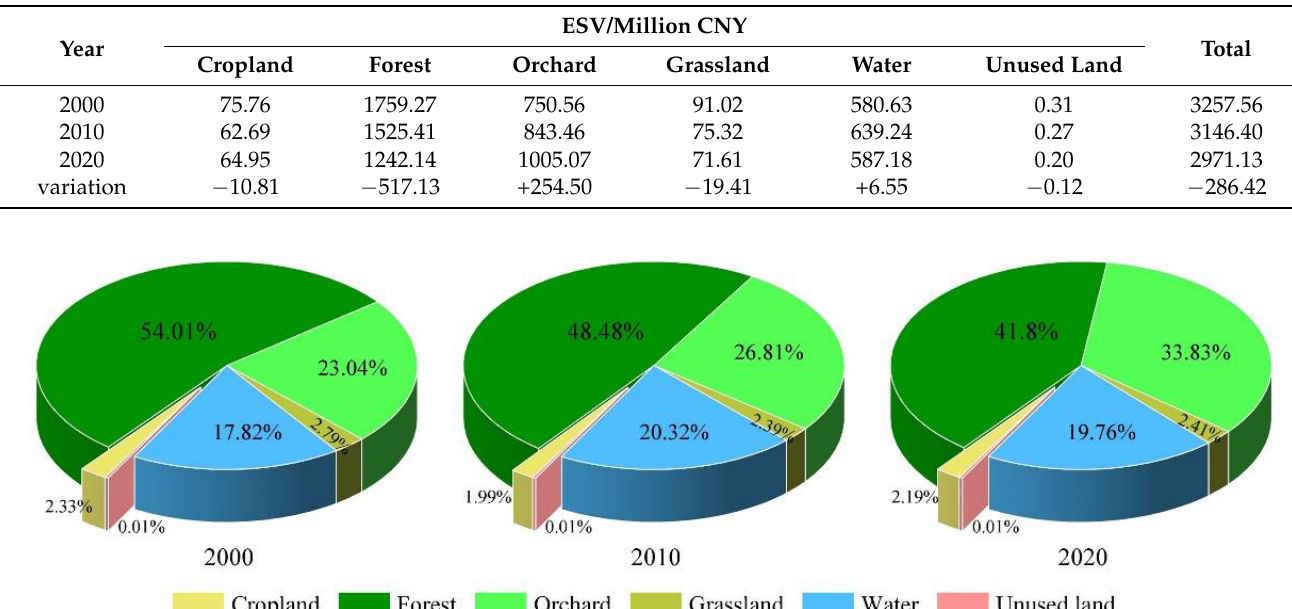
Table 7. The total static ESV in 2000, 2010 and 2020.